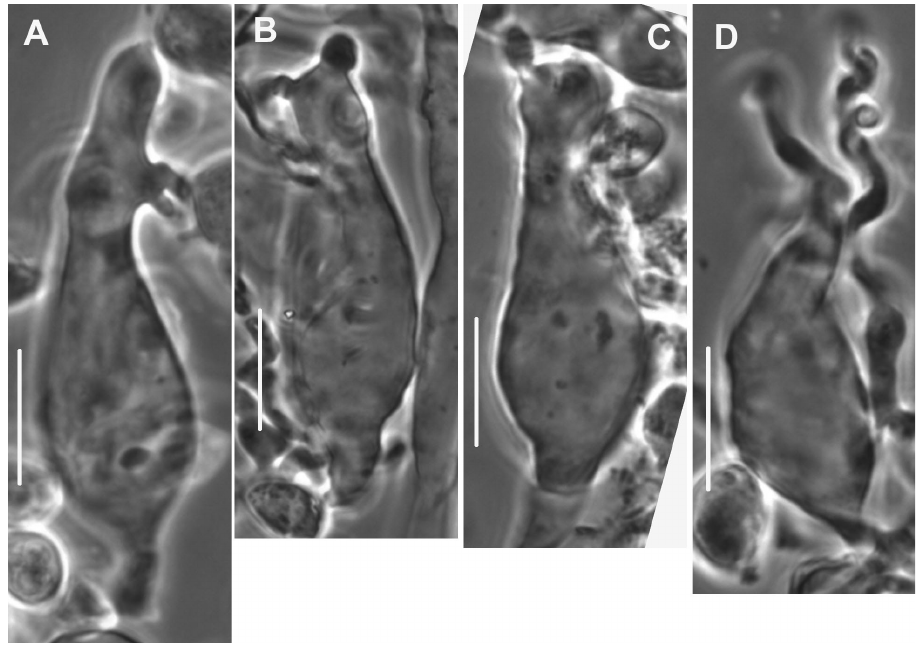
Figure 9. Mycetinis alliaceus . Cheilocystidia, showing adventitious apical outgrowths. Standard bars = 10 µm. TFB 4737